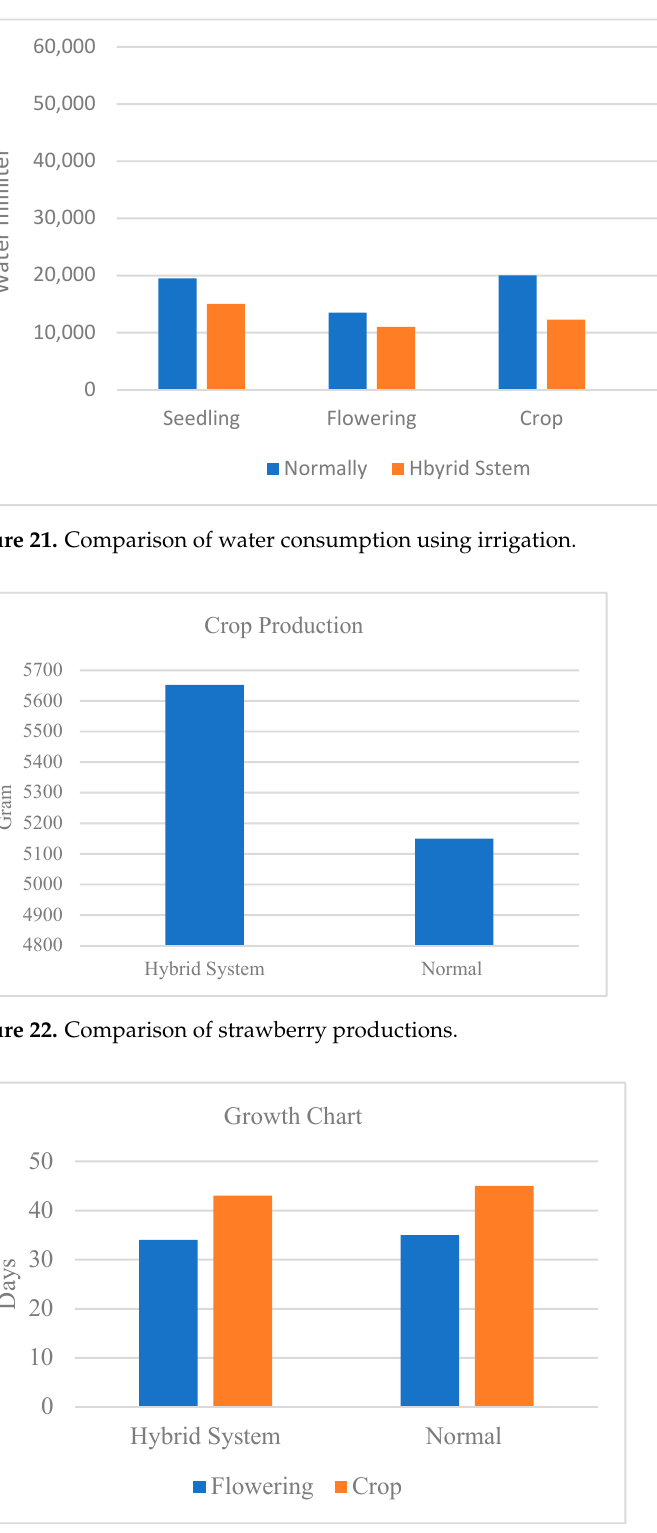
Figure 23. comparison of the growth times of the strawberry plant. Figure 23. Comparison of the growth times of the strawberry